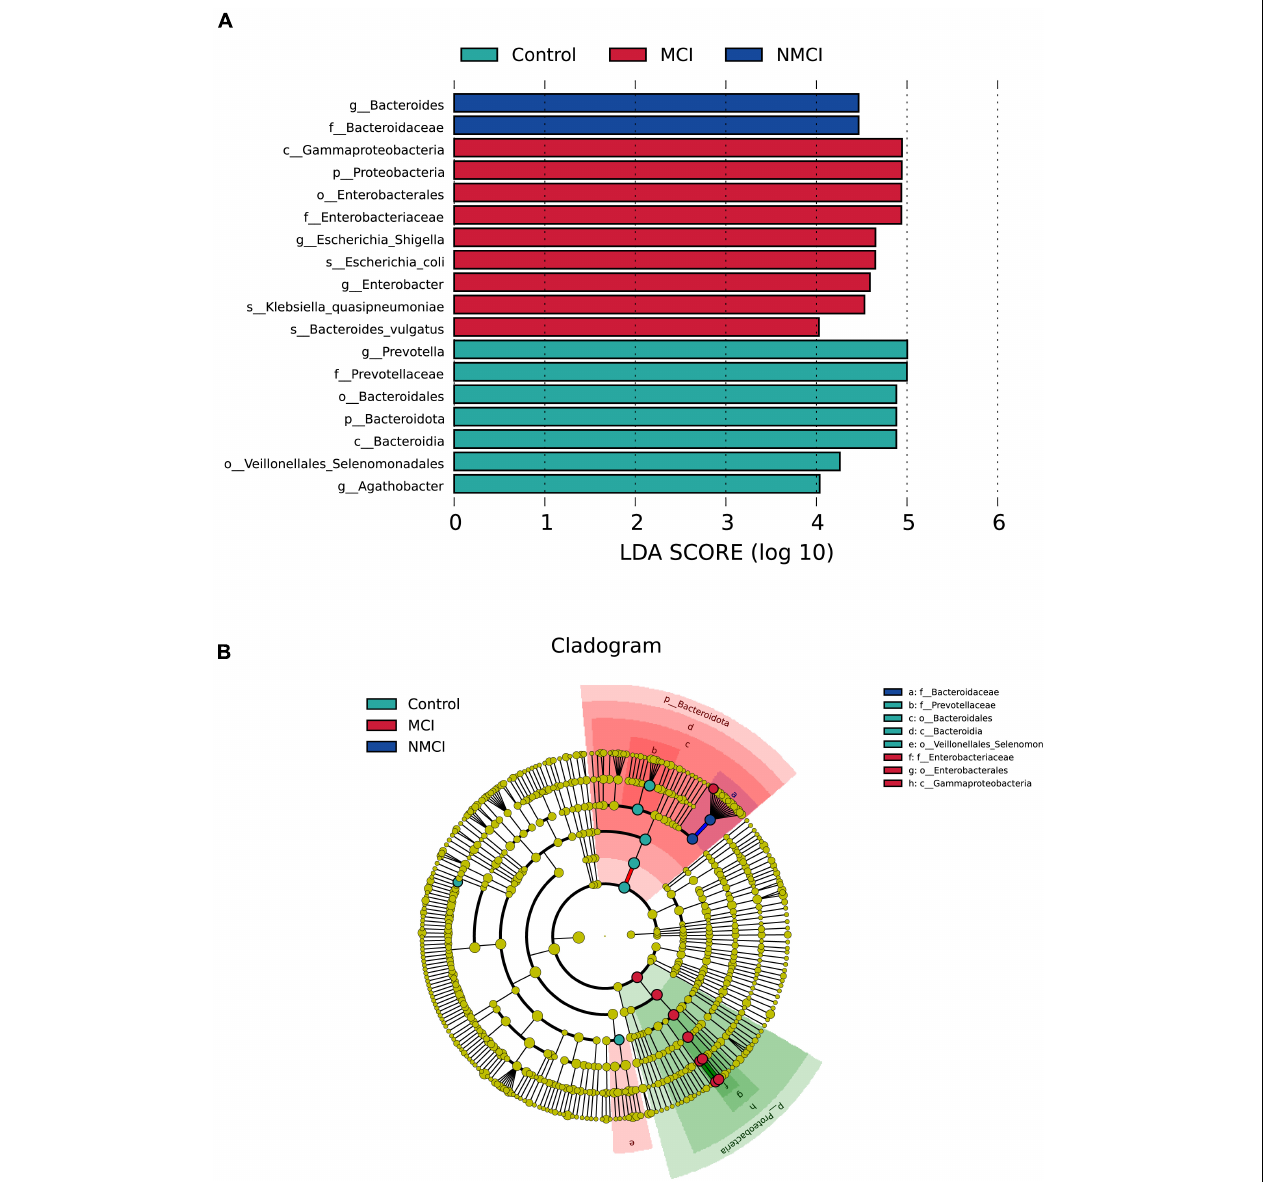
FIGURE 3 | Differences in the composition of intestinal flora. Linear discriminant analysis (LDA) effect size (LEfSe) analyses were performed to assess the difference in composition among the three groups. (A) LDA results showed the distinct taxa. (B) LEfSe results indicating the phylogenetic distribution of microbiota. Lowercase letters represent different classification levels; p, phylum; c, class; o, order; f, family; g, genus. MCI, hypertension patients with cognitive impairment; NMCI, hypertension patients without cognitive impairment; Control, health control subjects.